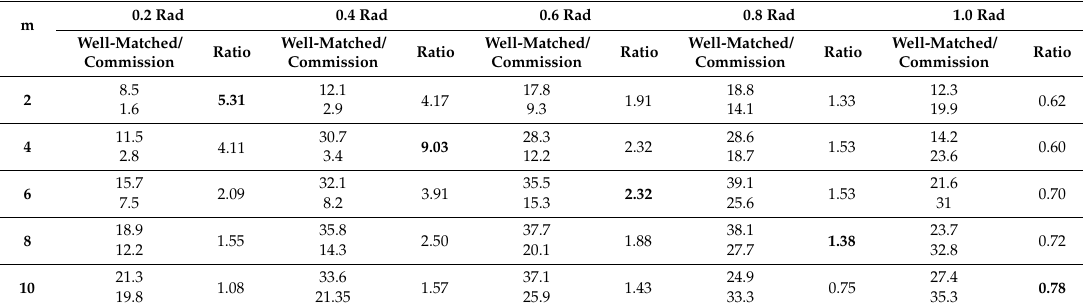
Table 4. Percentage distribution of matched points according to the Threshold fixed for Angular Shifts (TAS) and Threshold fixed for Length Shifts (TLS)